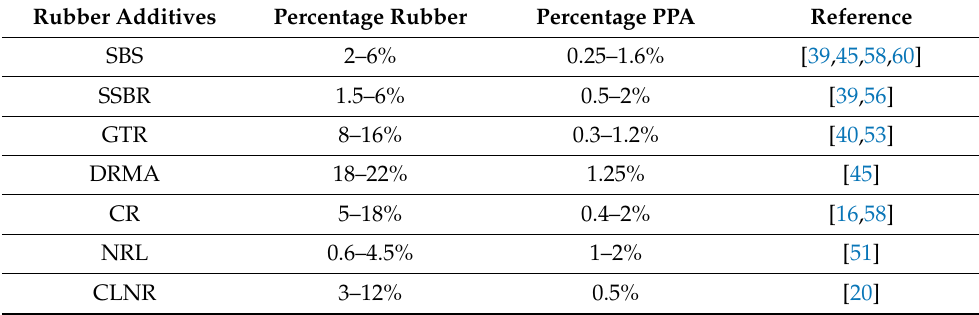
Table 5. Application of PPA in rubber polymers.